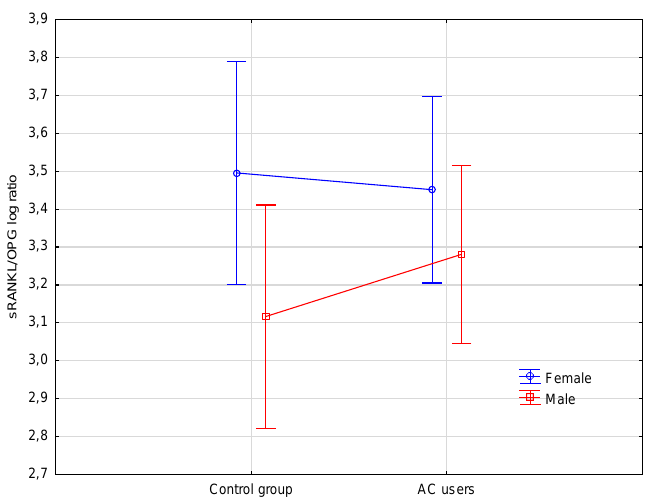
Figure 1. Levels of sRANKL/OPG log ratio in female and male controls, and female and male AC users. sRANKL, soluble receptor activator of nuclear factor-κB ligand; log, logarithm; AC, acenocoumarol; OPG, osteoprotegerin.